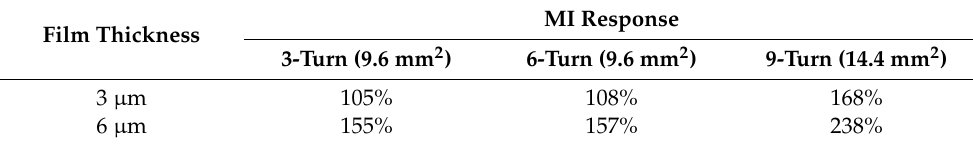
Table 3. MI response based on film thickness, sensing area size expressed in mm 2 , and number of turns taken by the